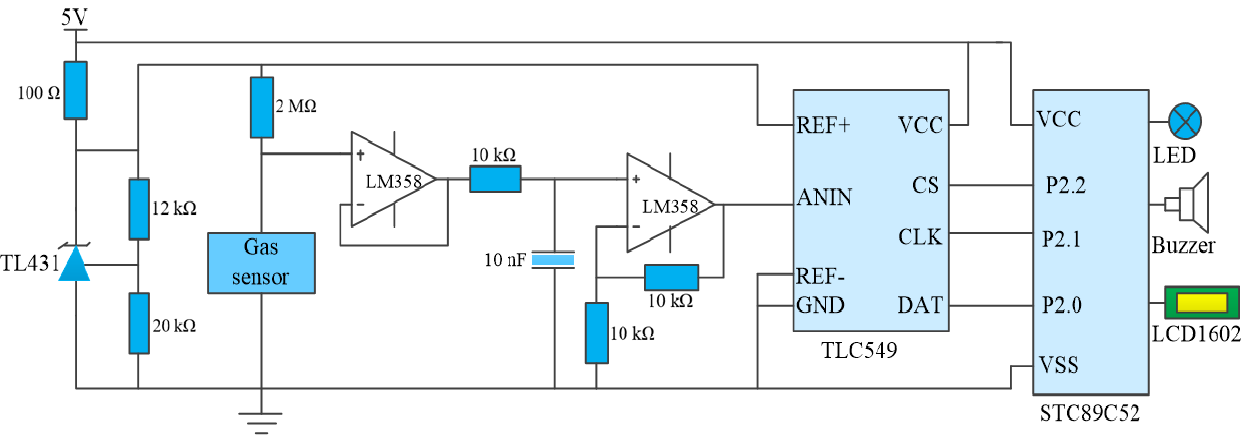
Figure 8. Block diagram of the integrated circuit alarm system.